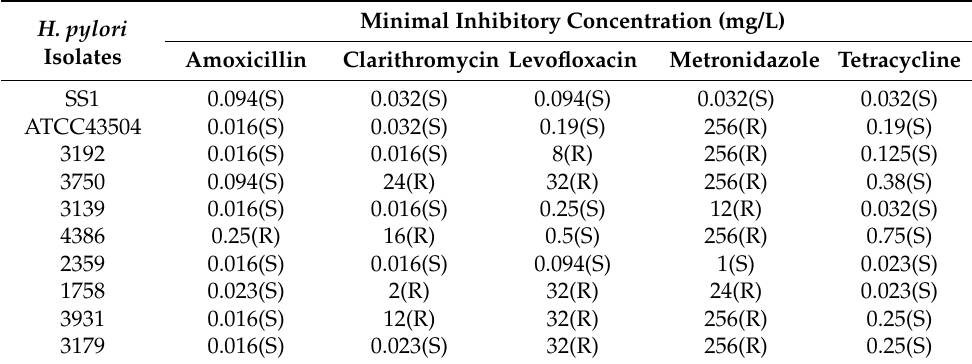
Table 2. Minimal inhibitory concentration of antibiotics for H. pylori isolates.